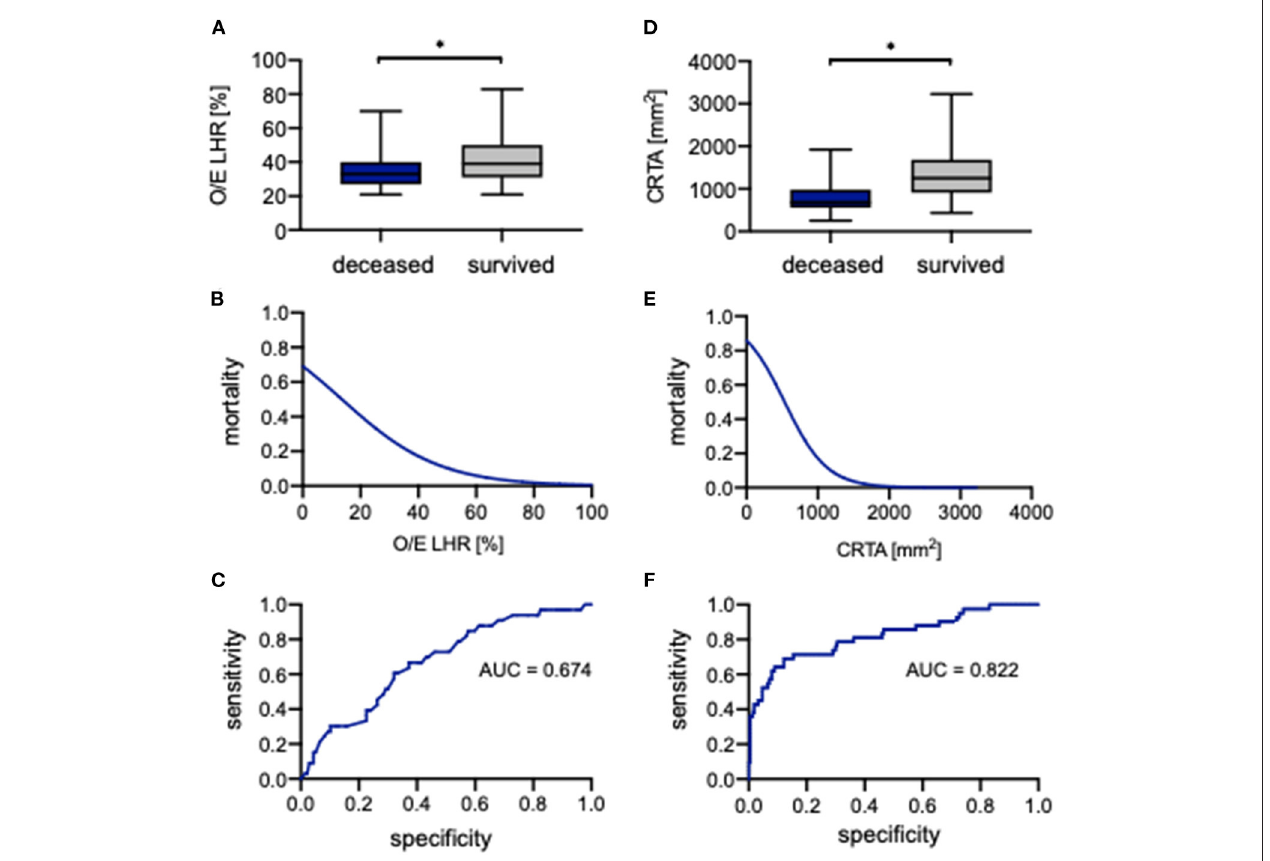
FIGURE 4 | Correlation of observed-to-expected lung-to-head ratio and CRTA to survival. Boxplots of (A) observed-to-expected lung-to-head ratio and (D) CRTA are exhibited for deceased and surviving infants (whiskers are shown as minimum and maximum). Also shown is the logistical regression (B,E) and ROC curve (C,F) of observed-to-expected lung-to-head ratio and CRTA for the prediction of mortality in the study population. *Significant difference in the U test. AUC, area under curve; CRTA, chest radiographic thoracic area; LHR, lung-to-head ratio; O/E,